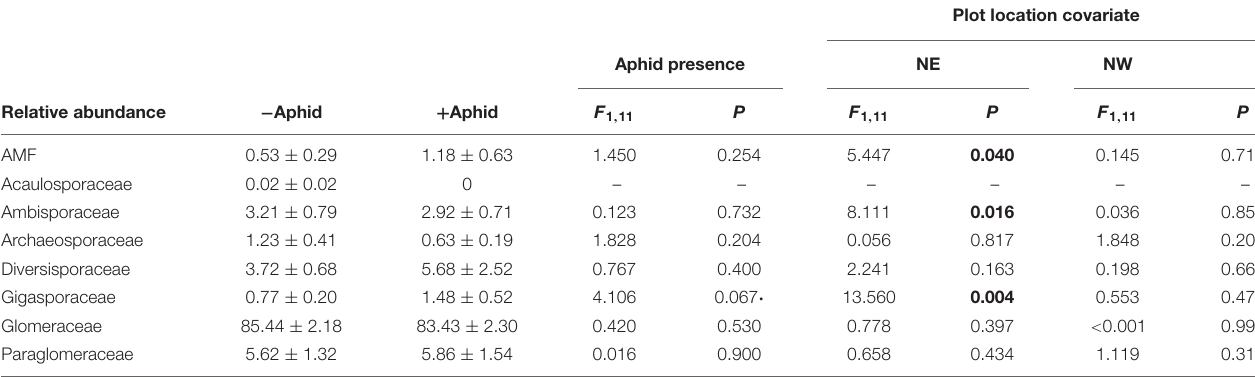
TABLE 5 | Mean ( ± SE) relative abundances of the AMF sequences within the “total fungi” amplicon, and of AMF family sequences from the “AMF specific amplicon,” from experimental barley plots infested with or without aphids, using the location of the plot in the NE and NW direction of the site as a model covariate. Plot location covariate Aphid presence NE NW